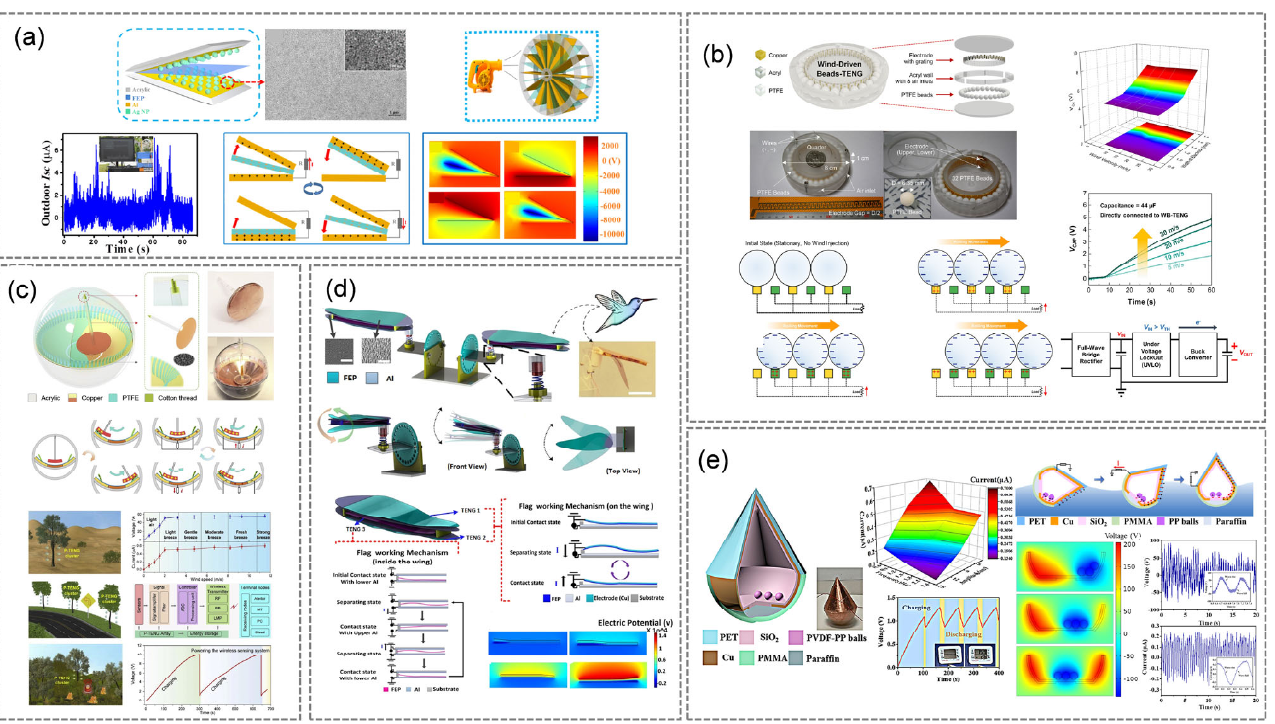
Figure 6. Various structures of wind ‐ driven triboelectric nanogenerators (WD ‐ TENG): ( a ) angle ‐ shaped triboelectric nanogenerator (reproduced with permission [54]. Copyright 2019, Nano Energy ). ( b ) TENG based on rolling motion of beads (reproduced with permission [55]. Copyright 2018, Nano Energy ). ( c ) A pendulum ‐ spired triboelectric nanogenerator (P ‐ TENG) (reproduced with permission [56]. Copyright 2019, Nano Energy ). ( d ) Bioinspired hummingbird ‐ wing ‐ stimulated TENG (reproduced with permission [57]. Copyright 2017, Scientific Reports ). ( e ) Tumbler ‐ shaped hybrid triboelectric nanogenerator (reproduced with permission [58]. Copyright 2020, Nano Energy ).